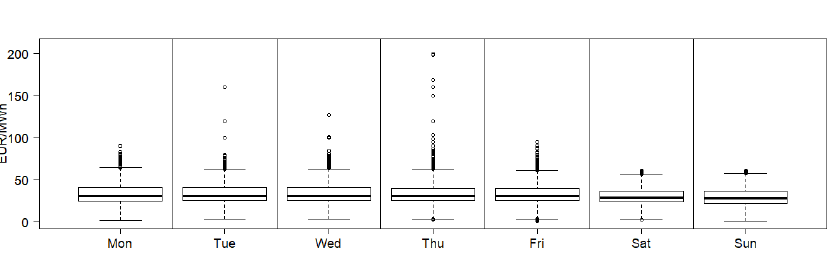
Figure 2. Boxplots of the electricity price for each hour of the day (29 December 2014–24 November 2019).